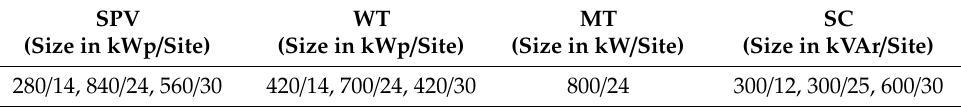
Table 3. Existing distributed generation (DGs) and SCs assumed in a 33-bus test system.